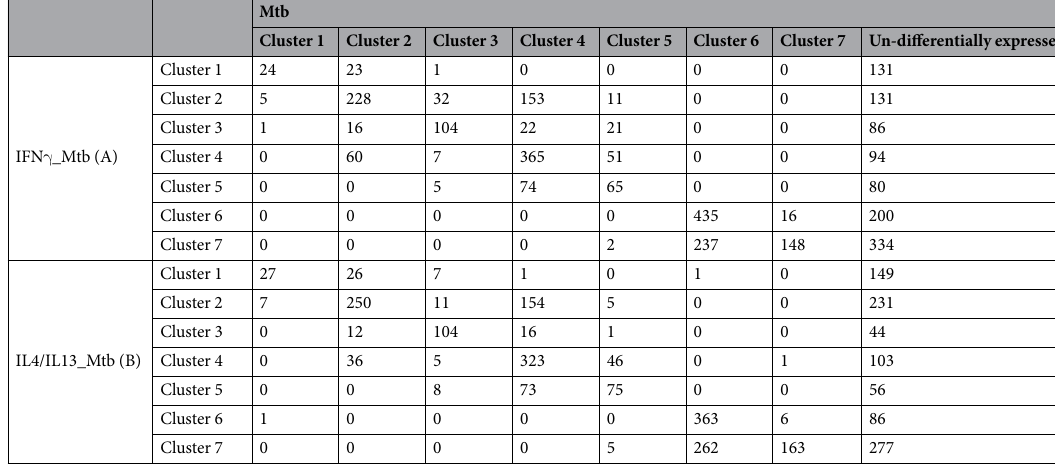
Table 2. Cluster distribution of differentially expressed genes between Mtb and IFN γ _Mtb (A) and between Mtb andIL-4/IL-13_Mtb